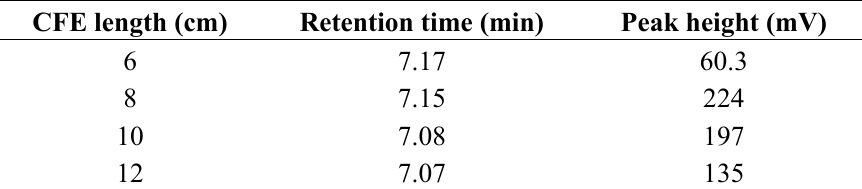
Table 1. Dependences of retention time and peak height cysteine (2.5 mg·L − 1 ) on the carbon fiber detector working length.